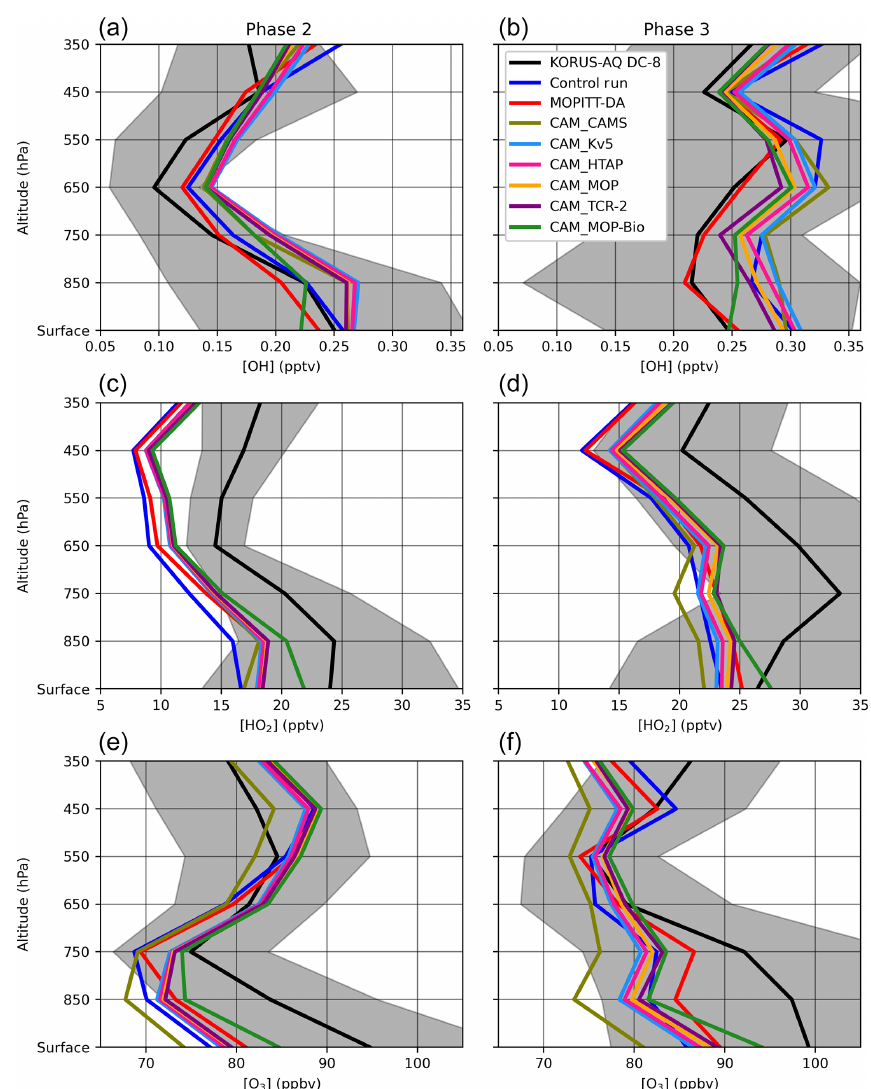
Figure 9. Average LaRC box model OH and HO 2 as well as measured O 3 for phase 2 (a, c, e) and phase 3 (b, d, f) of